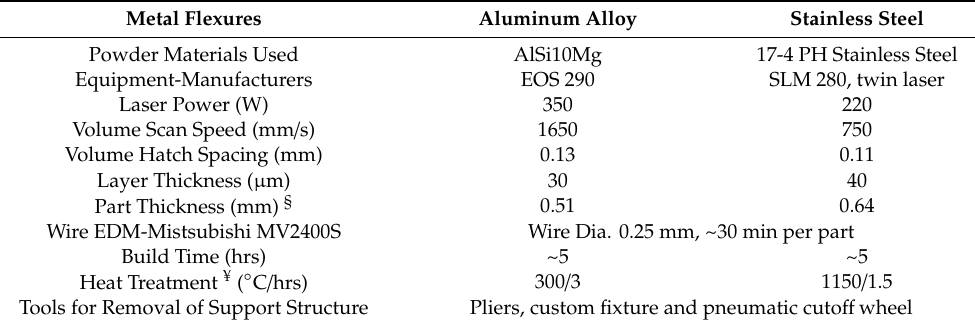
Table 2. Metal flexures—laser powder bed fusion.